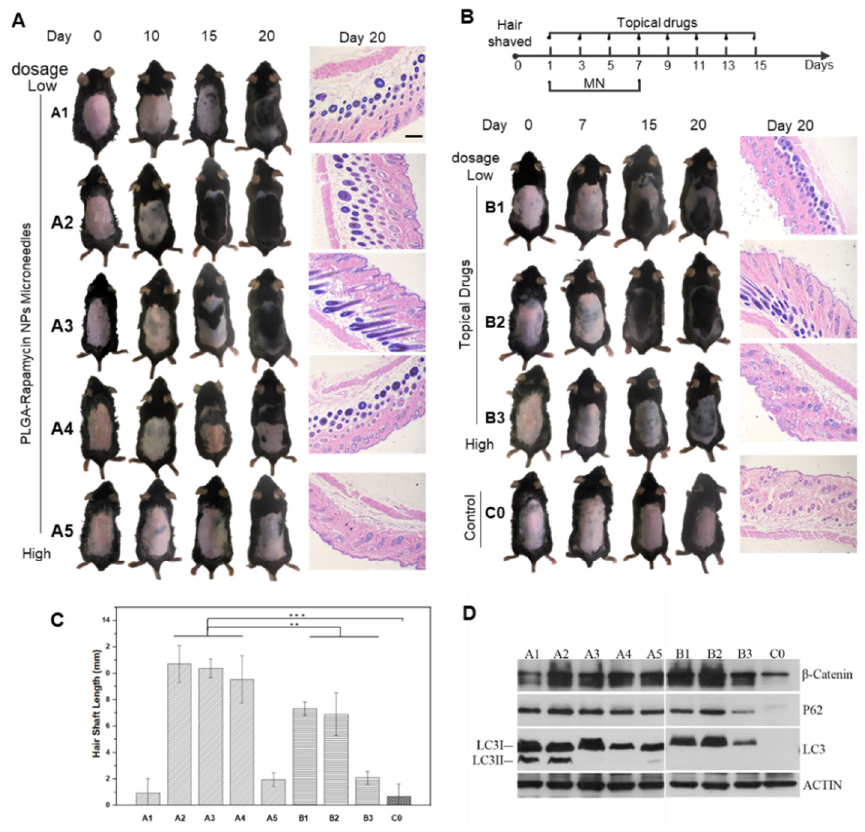
Figure 5. In vivo hair regrowth study by treatments with different dosages of rapamycin. ( A ) Schematic illustration of the hair loss treatments. ( B ) Physical and H&E staining images (scale bar: 100 µ m) of mice treated with RAPA-PLGA NP-loaded MNs and topical RAPA. The untreated mice served as a control. ( C ) Hair shaft analysis chart of new hair grown on treated mouse dorsal skin ( n = 3, mean ± SD). ( D ) Western blotting assay of the expression level of proteins related to hair follicle growth activation ( β -Catenin) and autophagy (p62 and LC3). A probability value ( p < 0.05) by t -test was considered significant (** p < 0.01, *** p < 0.001).